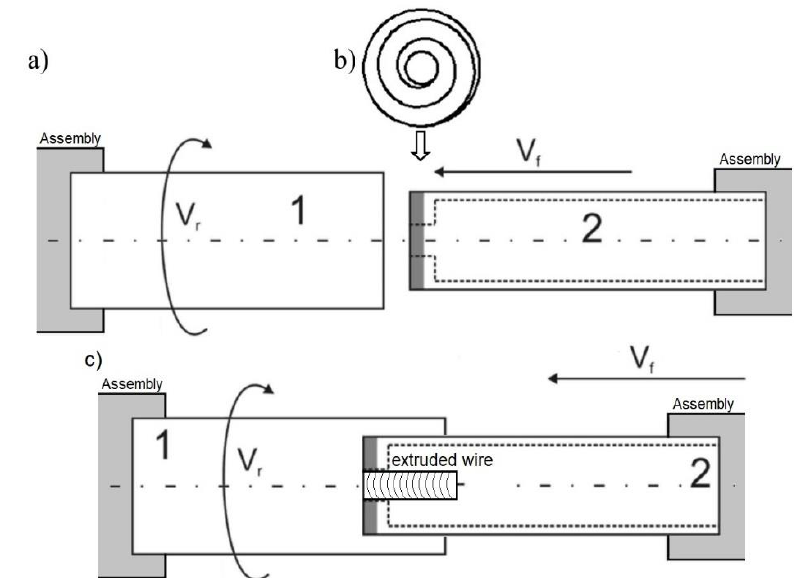
Figure 1. Scheme of the elaborated friction-extrusion experiment: ( a ) arrangement of the piece of the worked material (1) in relation to stamp (2) pressed into it, ( b ) spiral groove cut at the stamp face (shaded with gray) ( c ) during the process.